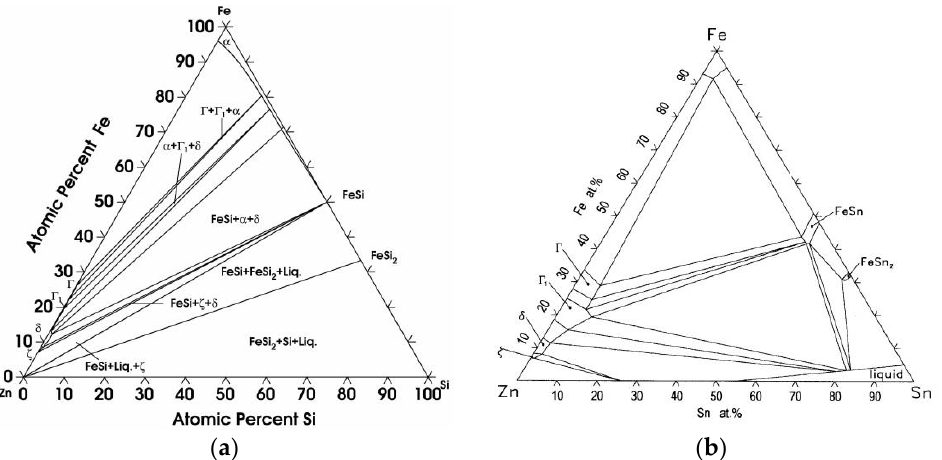
Figure 1. Ternary isothermal sections at 450 °C used as reference in the current study: ( a ) Zn-Fe-Si; Reproduction from [28], with permission of Taylor & Francis ( b ) Zn-Fe-Sn [31]. Reproduction from [31], with permission of Springer.